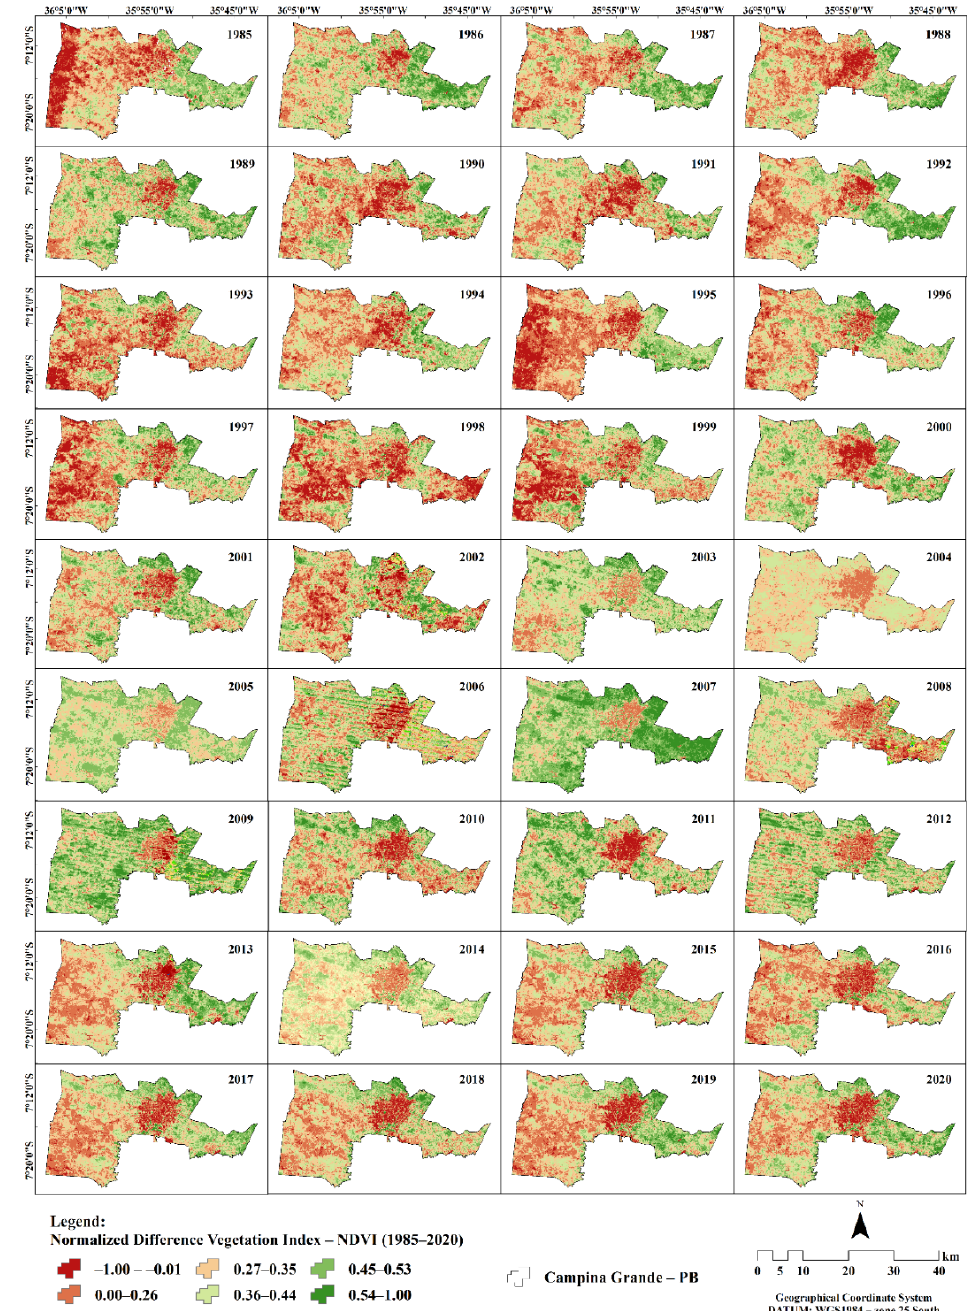
surface thematic maps, in the period 1985 and 2020. NDVI map results range from − 1.00 to 1.00.